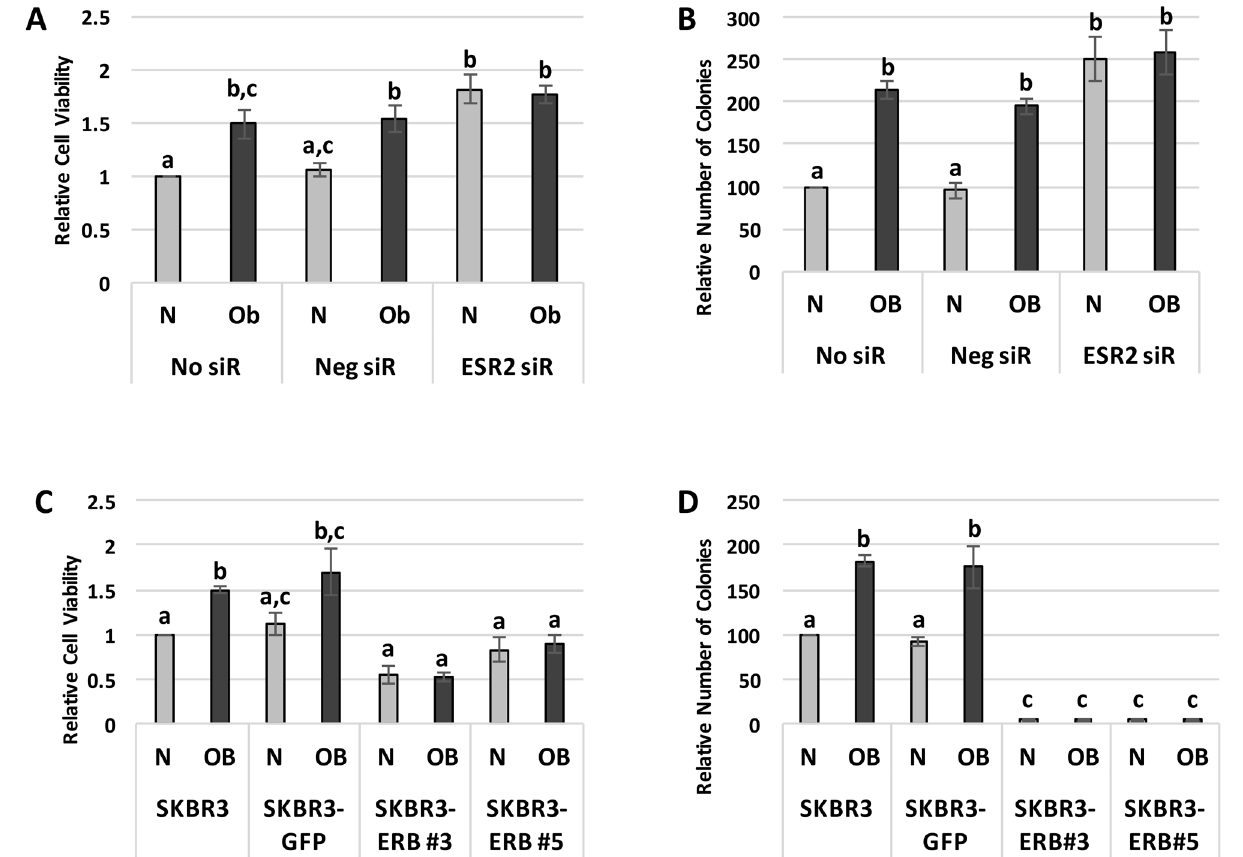
Fig 4. Breast cancer cell viability and growth are increased by the obesity-associated inhibition of ESR2 expression. (A) Cell viability, measured by MTT assay, in SKBR3 cells without transfection (No siR) or with transfection of a negative control siRNA (Neg siR) or siRNA to ESR2 (ESR2 siR) and following exposure to normal weight (N) or obese (OB) patient sera for 7 days. (B) Following 10 days of exposure to N or OB patient sera, colony formation was assessed in No siR, Neg siR, and ESR2 siR SKBR3 cells. (C) Viability of parental SKBR3 cells and SKBR3 cells stably transfected with an empty pGFP vector (SKBR3-GFP) or a GFP-tagged ESR2 overexpression plasmid (SKBR3-ERB#3 and #5) was measured by MTT assay after the cells were cultured in N or OB patient sera for 7 days. (B) Following 10 days of exposure to N or OB patient sera, colony formation was assessed in parental SKBR3, SKBR3-GFP, and SKBR3-ERB#3 and #5 cell lines. Data shown represents the average of at least three independent experiments. Different letters indicate statistically significant differences, p <